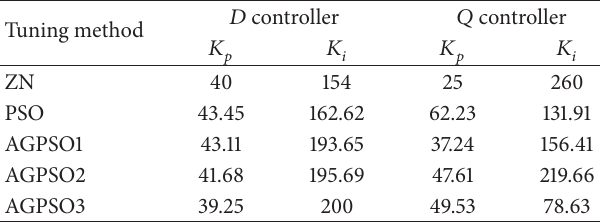
Table 8: Operating points of PI controllers for rectifier